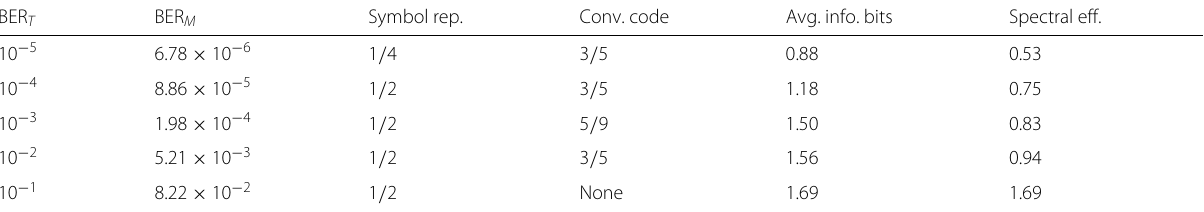
Table 2 The results from the simulated annealing optimization using the PMW and PFD approach BER T BER M Symbol rep. Conv. code Avg. info. bits Spectral